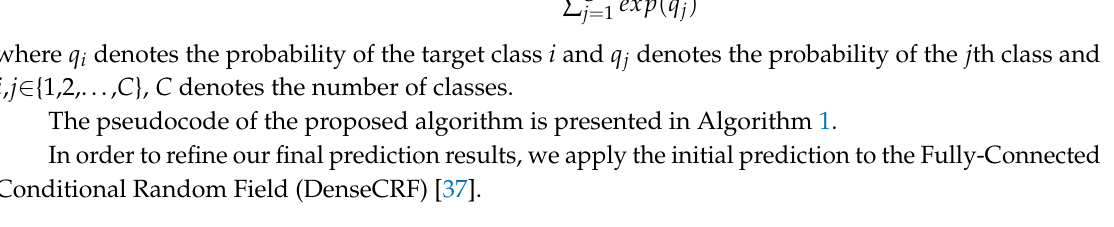
Algorithm 1 Disparity estimation algorithm based on an asymmetric